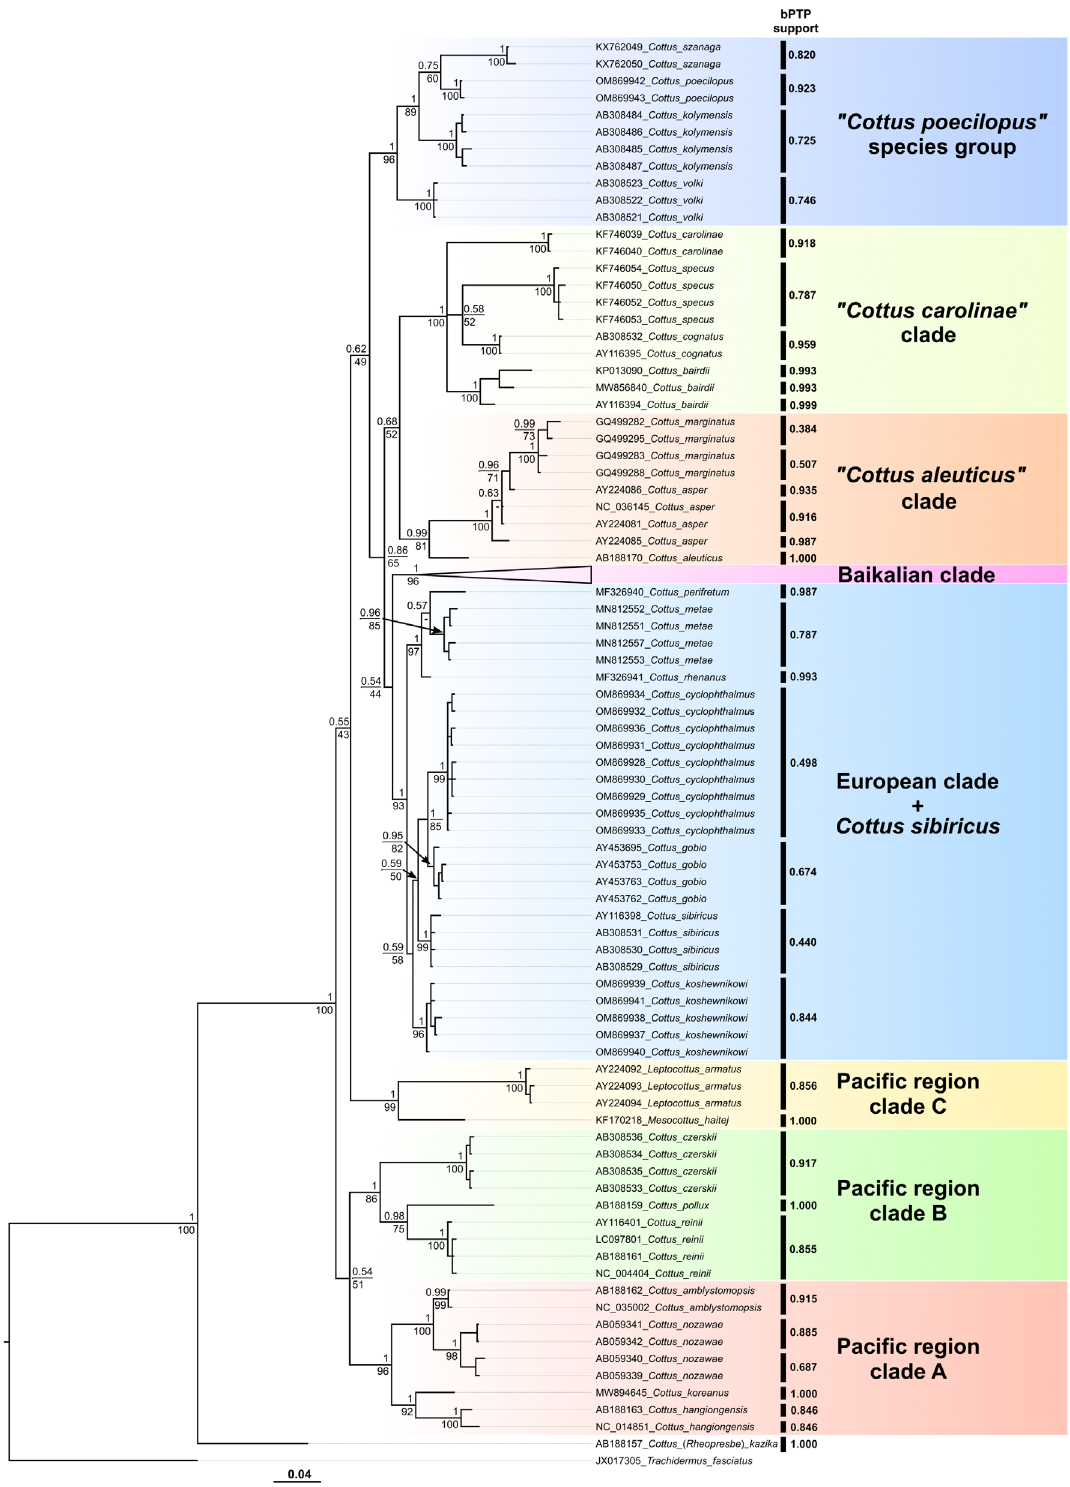
Fig. 6. Bayesian phylogenetic tree of the freshwater species of Cottidae reconstructed using mtDNA control region sequences. Bayesian posterior probabilities (on the top side) and bootstrap values from a ML analysis (on the down side) are shown. Results of species delimitation with bPTP support values are